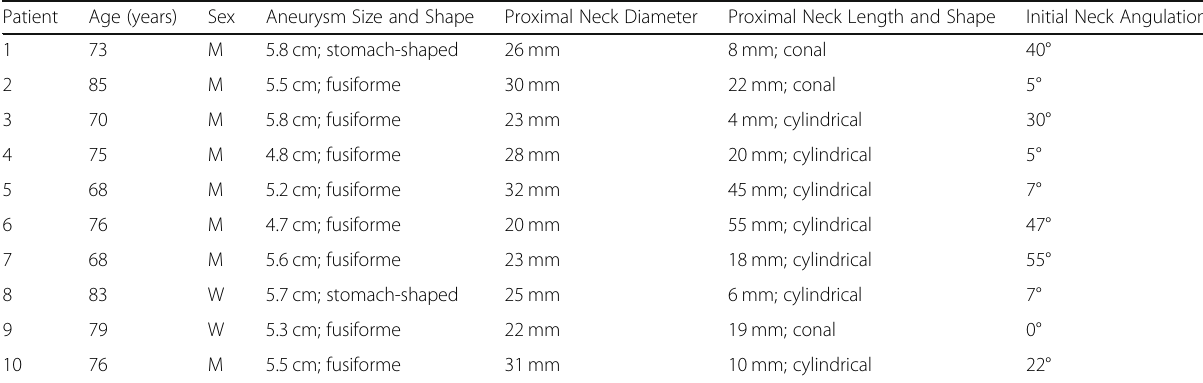
Table 1 Patient data and characteristics of abdominal aorta aneurysms Patient